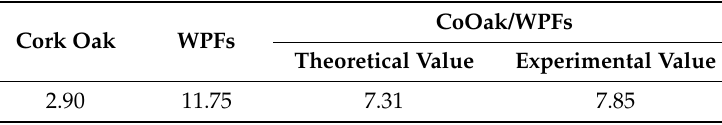
Table 1. The yields of aromatic hydrocarbons obtained from the catalytic pyrolysis of CoOak, WPFs, and their mixture (Unit: wt %).